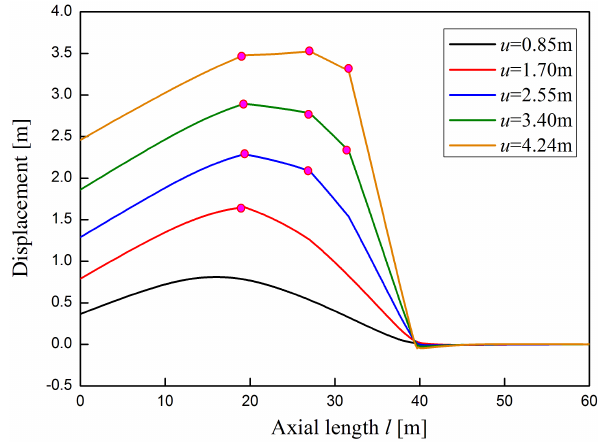
Figure 7. Bending deformations of the buried pipeline under dif- ferent fault